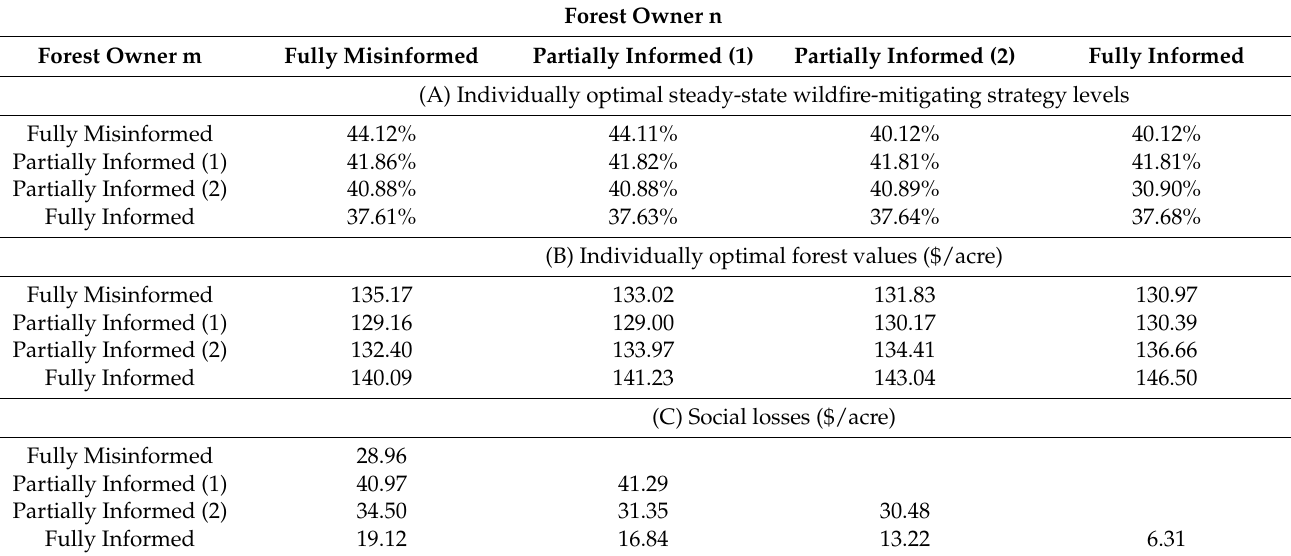
Table 2. Baseline outcomes for forest owner m given different misinformation scenarios. Forest Owner